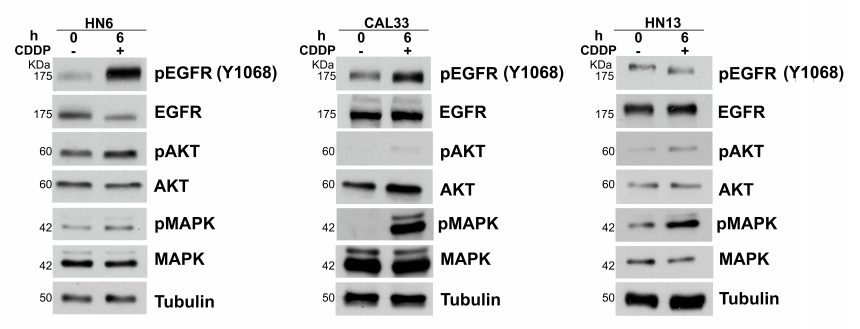
Figure 3. The activation of the EGFR pathway following CDDP exposure in HN6 ( A ), CAL33 ( B ), and HN13 ( C )